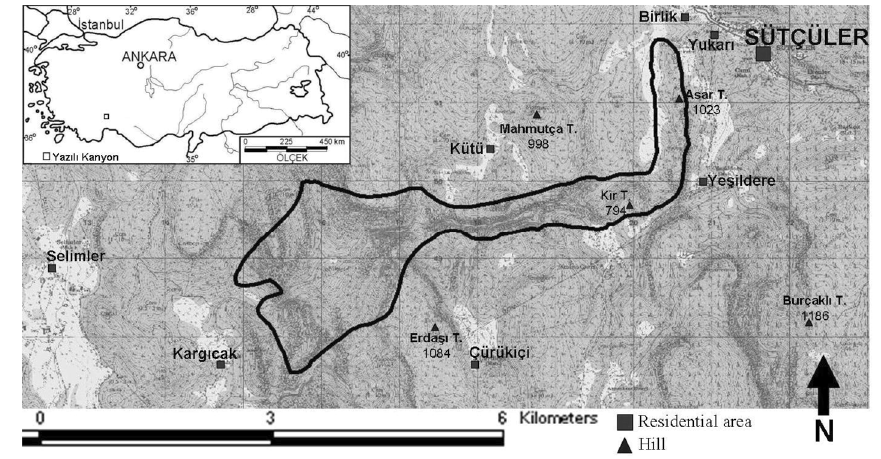
Fig. 1. Location of Yazili Canyon Nature Park in Sutculer Distric